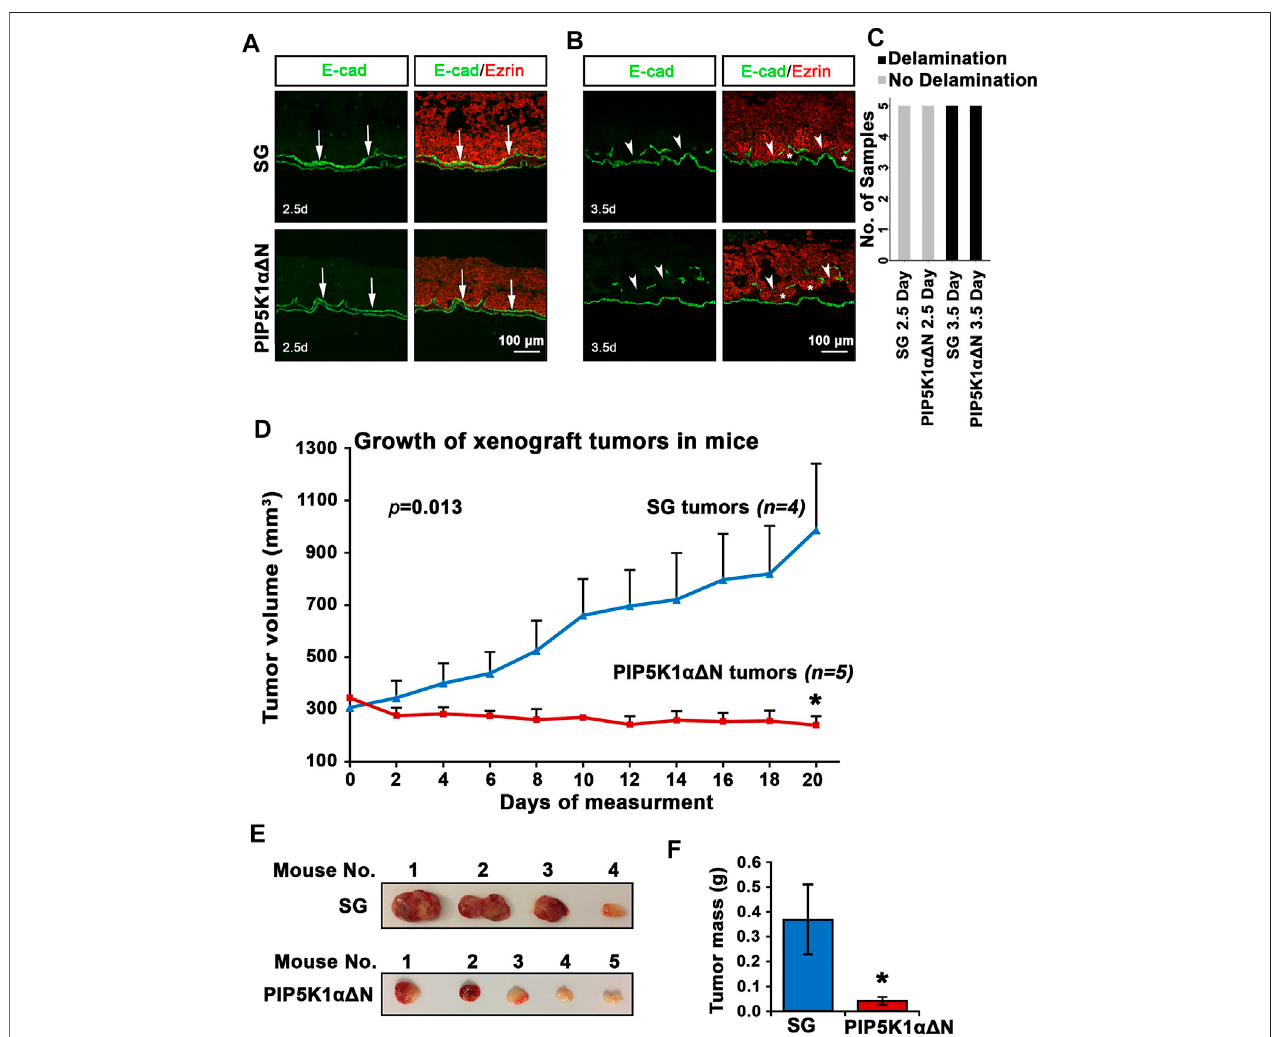
FIGURE 8 | Biological consequences of N-terminal truncated PIP5K1 α cells on delamination, initial in fi ltration, tumor growth and progression. (A – C) SG cells and PIP5K1 αΔ N cells cultured for 2.5 and 3.5 days in the CAM-Delam assay. SG and PIP5K1 αΔ N cells are identi fi ed by Ezrin (red) and the chick basal lamina by laminin- producing E-cadherin positive cells (green). (A) At 2.5 days, no delamination or cell in fi ltration was detected ( n = 5). (B) After 3.5 days, both SG and PIP5K1 αΔ N cells cause disruption of the basal lamina and cell in fi ltration into the mesenchyme ( n = 5). Arrows indicate intact basal lamina (A) and disrupted basal lamina (B) , and asterisksindicateSGandPIP5K1 αΔ Nin fi ltratedcellsAbbreviationd:days.Scalebar:100 μ m.AbargraphoftheCAM-Delamscoring (C) . (D) XenografttumorsfromSG cells and PIP5K1 αΔ N cells were established in nude mice. The measurement of tumor started when tumor grew steadily after inoculation. The tumors were measured every second day for 20 days. Mean tumor volumes are shown. (E) Representative images of tumors from each group are shown. (F) Mean tumor mass in weight from xenograft mice bearing SG tumors and PIP5K1 αΔ N tumors are shown. Student ’ s t -test is used. * p < 0.05 is indicated.